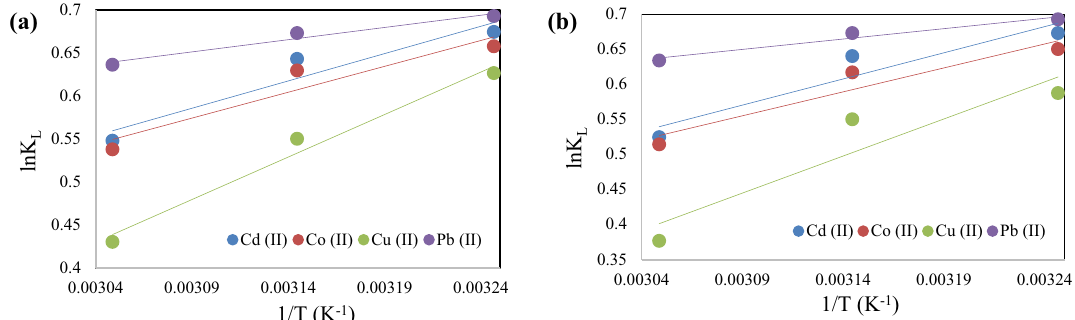
Figure 10. van’t Hoff plots for the adsorption of Cd (II), Co (II), Cu (II) and Pb (II) ions on ( a ) TPP-CMN and ( b ) V-CMN